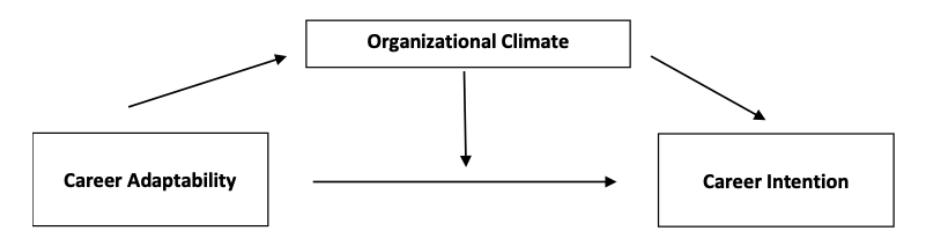
Figure 1: Conceptual